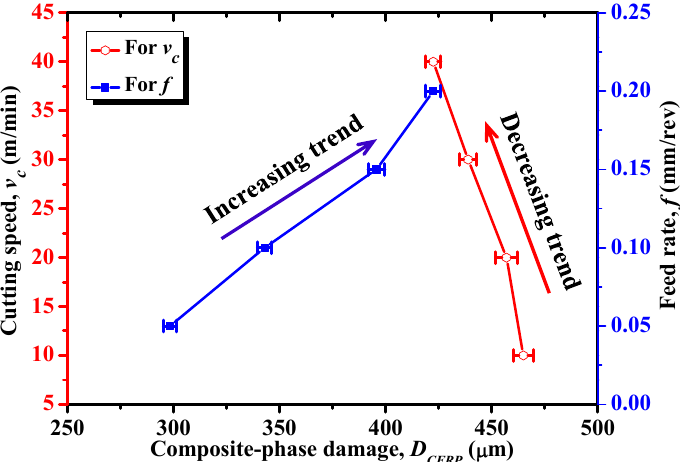
Figure 18. Effects of cutting speed ( v c ) and feed rate ( f ) on composite ‐ phase damage extent ( D CFRP ) ( θ = 0°).